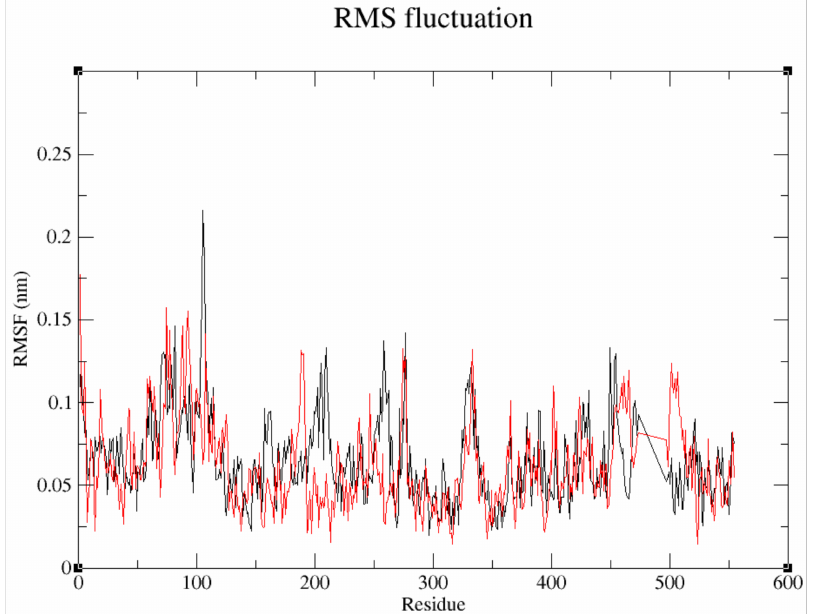
Figure 6. Root mean square fluctuation (RMSF) plot of fenoxaprop-p-ethyl (black) and sinigrin (red) ACCase complex structures over 100 ns